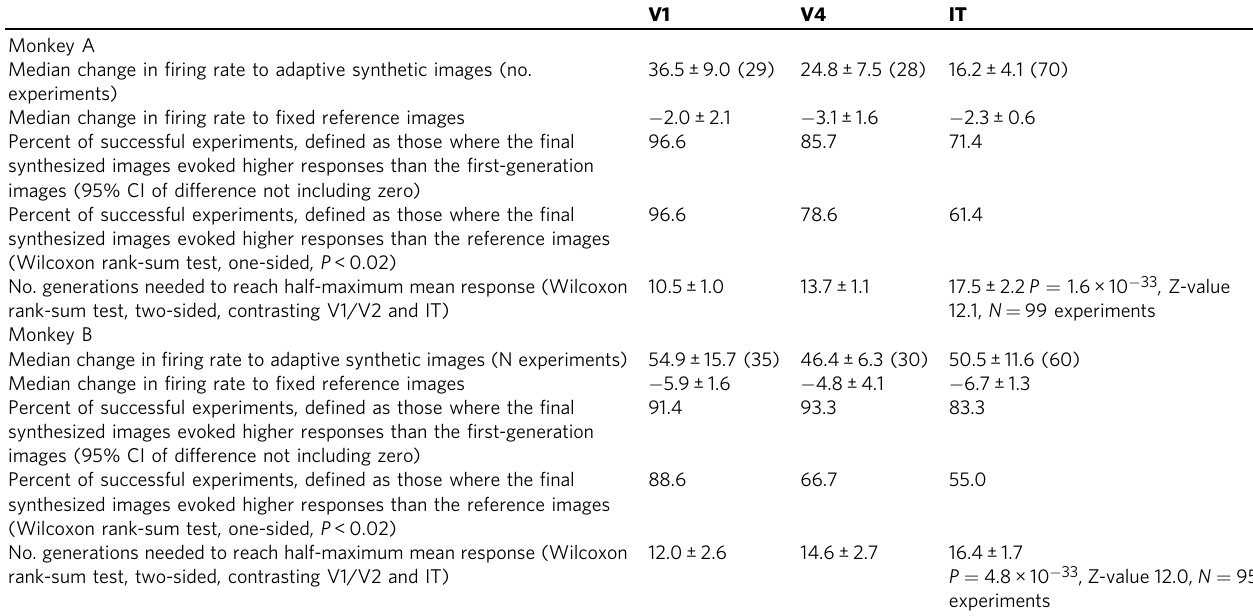
Table 3 Prototype synthesis